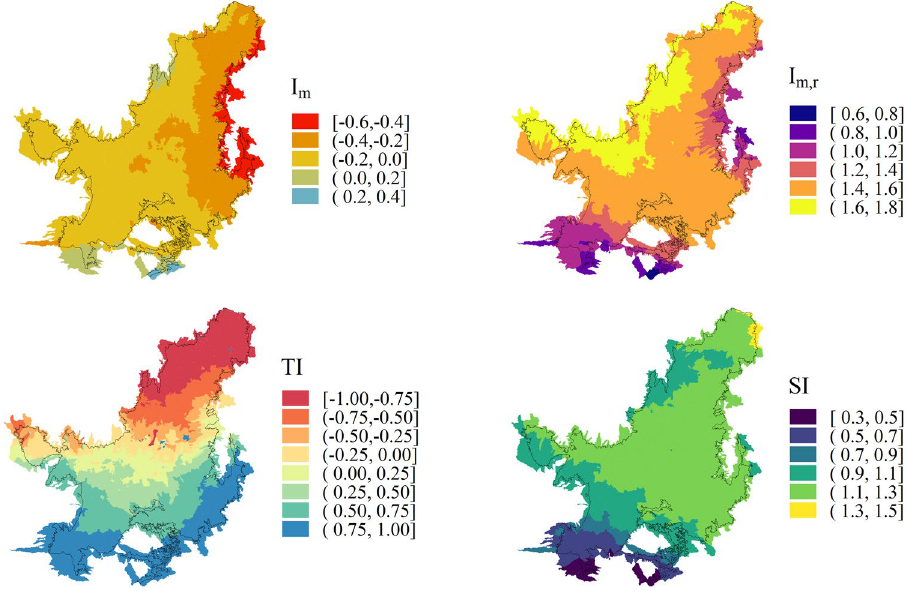
Fig. 4 Climate indices for the level 5 ottobasins. I m = moisture index, I m,r = moisture index seasonality, SI = precipitation seasonality index, and TI = pre- cipitation timing